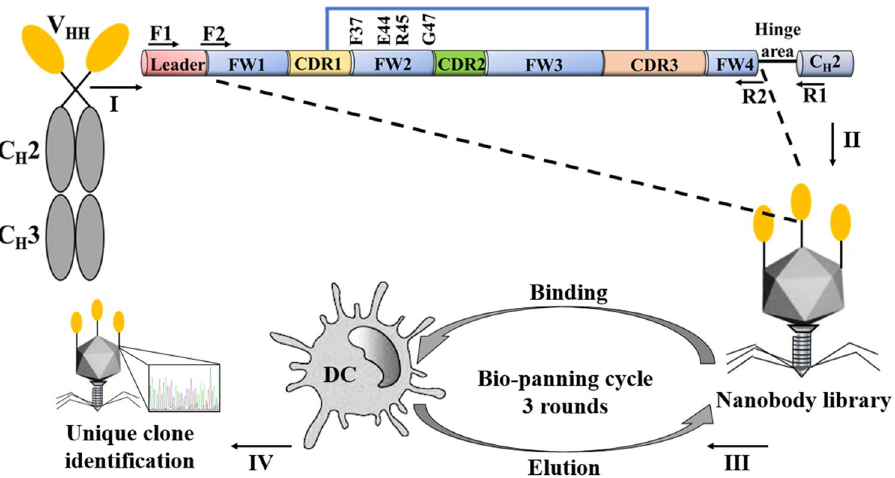
Figure 1. Schematic of T7 phage display nanobody library construction and bio-panning. Schematic of strategies used to construct the nanobody library, bio-panning of dendritic cell (DC)-specific binding VHHs, and sequence analysis of single phage plaque clones. (I). Molecular structure of nanobody. (II). The nanobody VHH genes were inserted into the T7 phage genome to rescue the nanobody library. (III). The bio-panning cycles of chicken DCs. (IV). Sequence analysis of a single phage